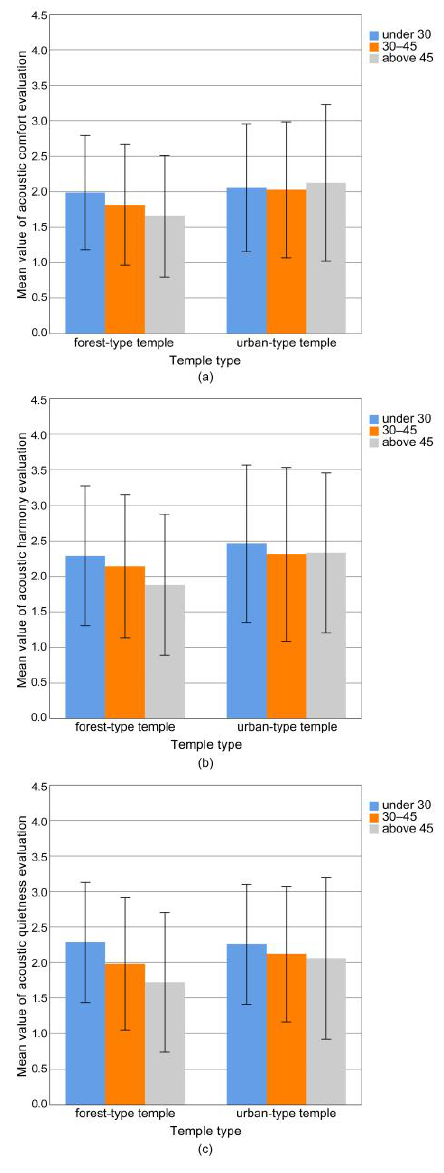
Figure 3. The evaluation value and standard deviation of acoustic environment by different respondents’ age: ( a ) comfort; ( b ) harmony; ( c ) quietness.